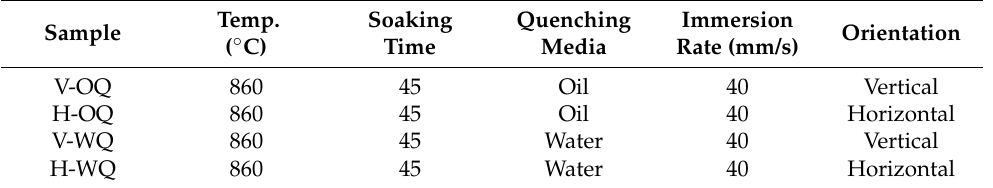
Table 2. Quenching process conditions for AISI 4340 steel.